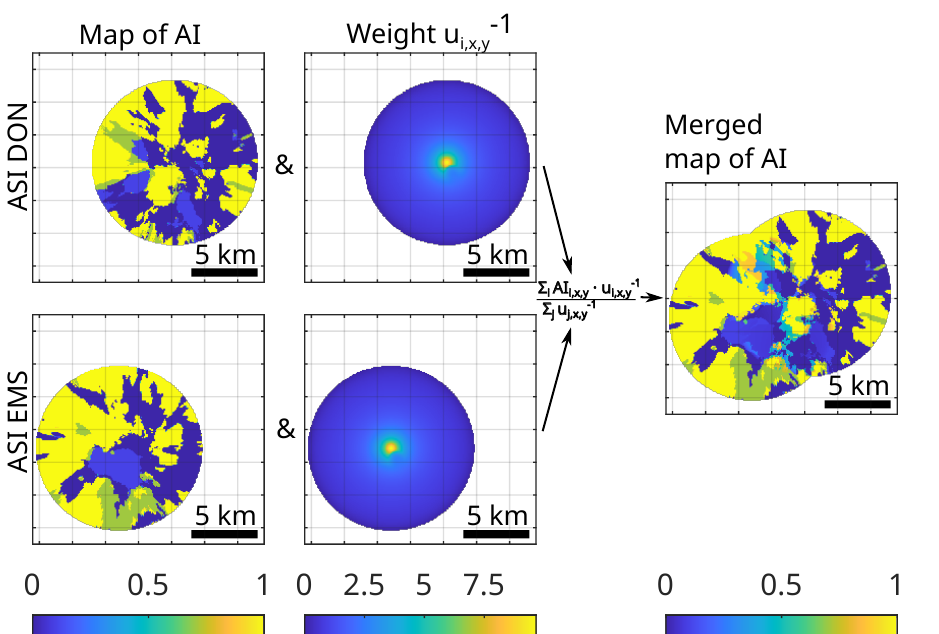
Figure 5. The accuracy-weighted combination procedure is demonstrated exemplarily with only two all-sky imagers (ASI). The evaluated timestamp is 5 June 2020, 10:22:00. Each ASI i delivers a georeferenced map of attenuation index AI i ( left column ); the map of AI from each ASI is weighted with u − 1 ( center column ), the inverse of the expected local uncertainty of AI ; the weighted average i , x , y from the included ASIs yields the merged map of AI ( right column based on AI i , x , y · u − 1 i , x , y